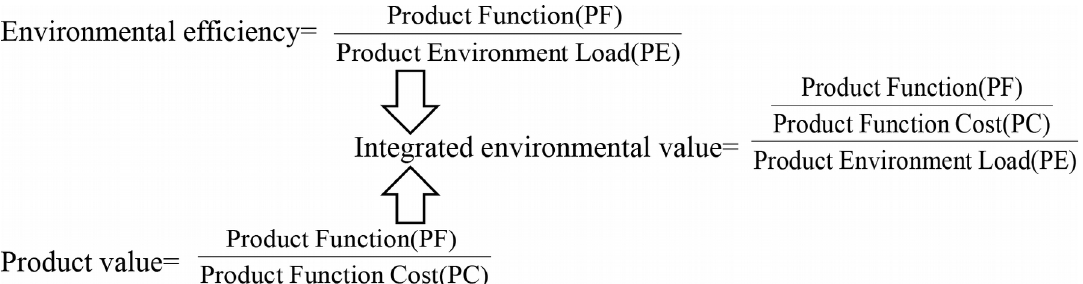
Figure 6. The concept of products environmental integrated